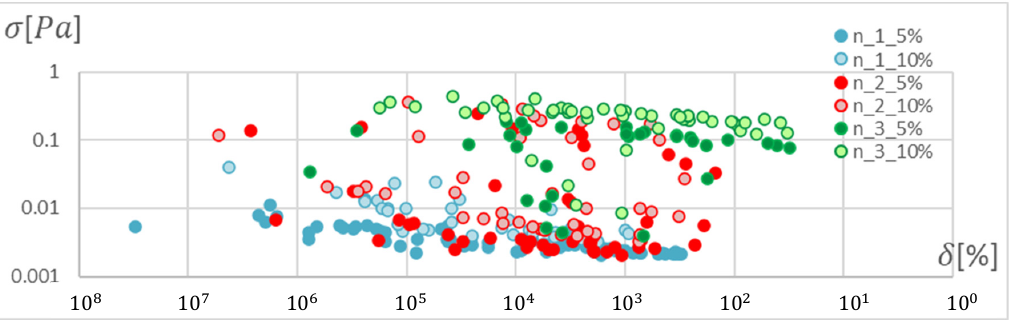
Figure 15. Pareto fronts for the two best-matched networks trained using the SCG algorithm. Figure 16. Pareto front for all studied networks trained using the RPROP algorithm.